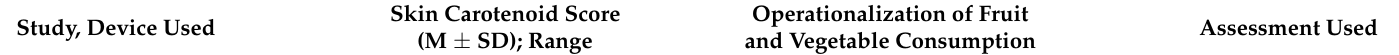
Table 3. Validity of reflection spectroscopy-based skin carotenoid assessment in children as a proxy for fruit and vegetable